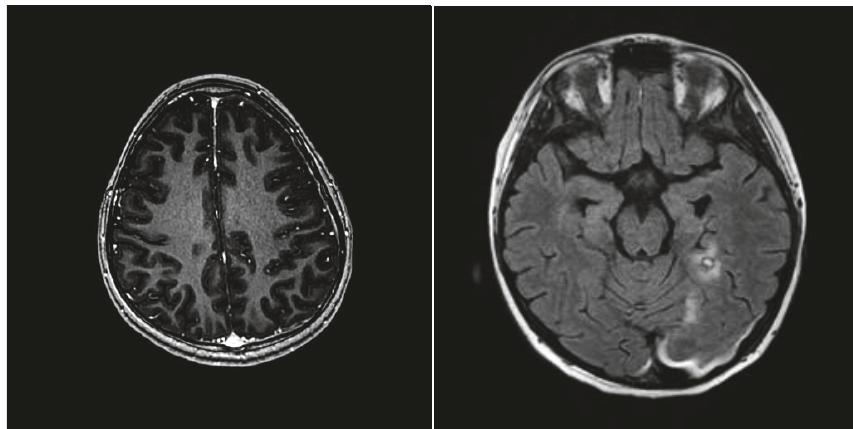
Figure 2: MRI Brain FLAIR images demonstrating multicompartmental hemorrhages and leptomeningeal enhancement.